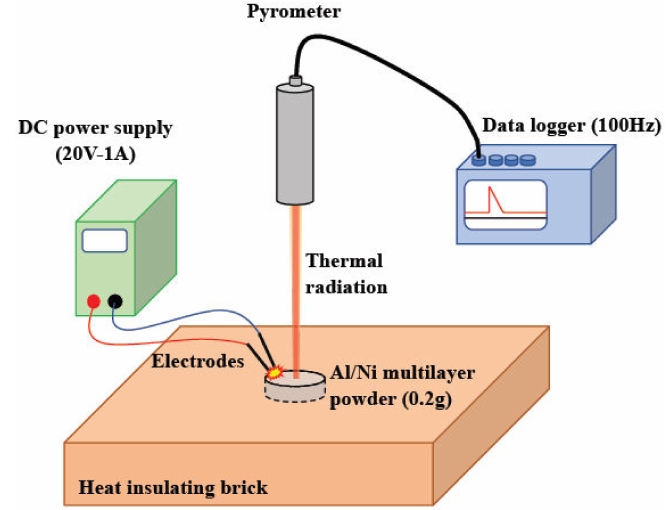
Figure 2. Experimental setup for the temperature measurement during the exothermic reaction by the high-speed pyrometer.